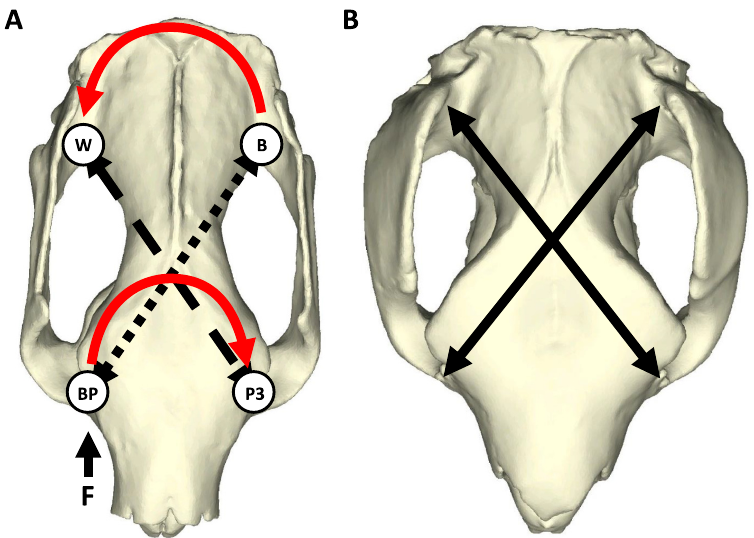
Fig 6. Torsional arcs during a unilateral bite. (A) A koala cranium performing a unilateral premolar bite. As the biting premolar “BP” receives a reaction force “F” from a hard food item, the anterior cranium rotates clockwise along the axis between “BP” and the opposite premolar “P3”. At the same time, the balancing TMJ “B” rotates anticlockwise along the line to the working-side TMJ “W” in response to the higher joint reaction forces at “B”. This produces compressive forces (short dashes) along the surface of the cranium between “BP” and “B”; and tensile forces (long dashes) between “P3” and “W”. (B) The enlarged frontal plates of Simosthenurus occidentalis follow these helical arcs of compression and tension (unbroken lines) by expanding from the anterior brain case to the supraorbital tuberosity above the cheek tooth row.